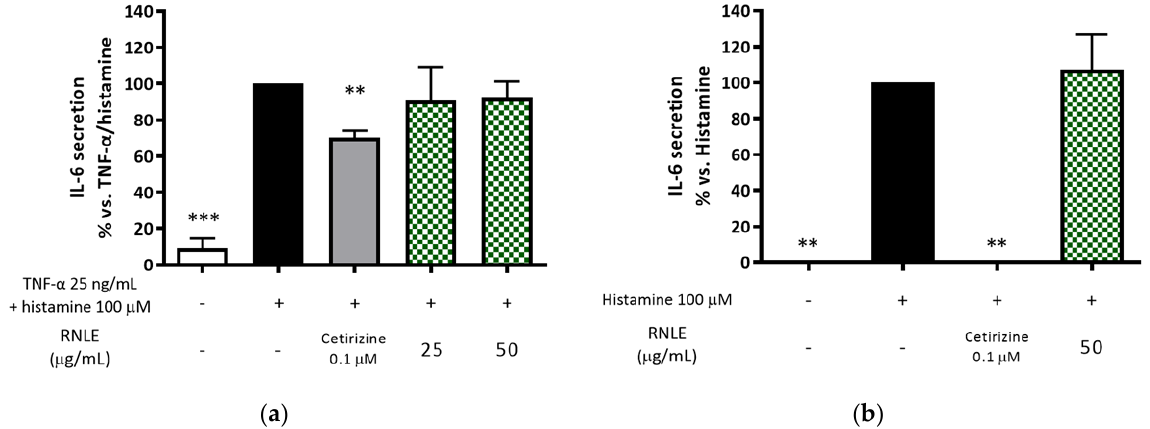
Figure 13. ( a ) Effect of RNLE treatment (25–50 µg/mL) on IL-6 secretion in HaCaT cells stimulated with a combination of histamine and TNF-α (100 µM + 25 ng/mL, 24 h); the amount of IL-6 in the stimulated condition was 64.50 ± 25.85 pg/mL. ( b ) Effect of RNLE treatment (25–50 µg/mL) on IL-6 secretion in HaCaT cells stimulated with histamine (100 µM, 24 h); the amount of IL-6 in the stimulated condition was 3.20 ± 1.10 pg/mL. Cetirizine 0.1 µM was used as the reference compound; ** p < 0.01, *** p < 0.001 vs. stimulus.